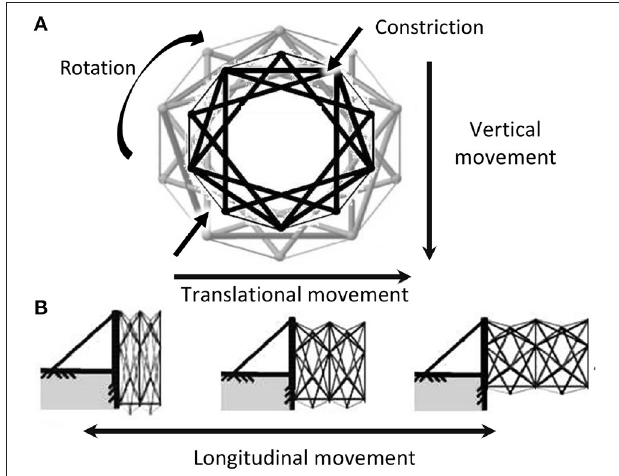
FIGURE 3 | Front (A) and side (B) views of translations, vertical, longitudinal movements of the deployable tensegrity structure. The sketch does not show the effect of gravity and translational movement of the section due to continuous cable